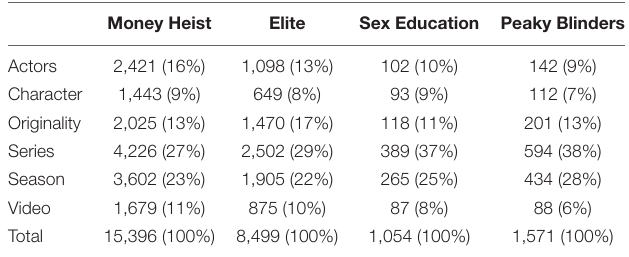
TABLE 9 | Frequencies and percentages of the mentions regarding form and content.